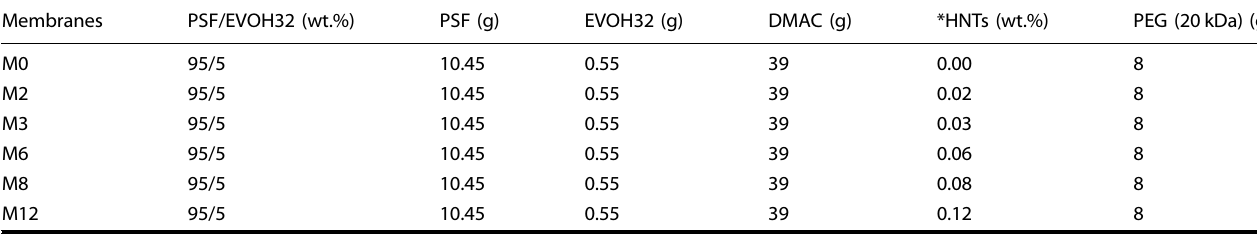
Table 3. Composition of dope solutions for the PSF/EVOH32/HNTs mixed matrix membranes. Membranes PSF/EVOH32